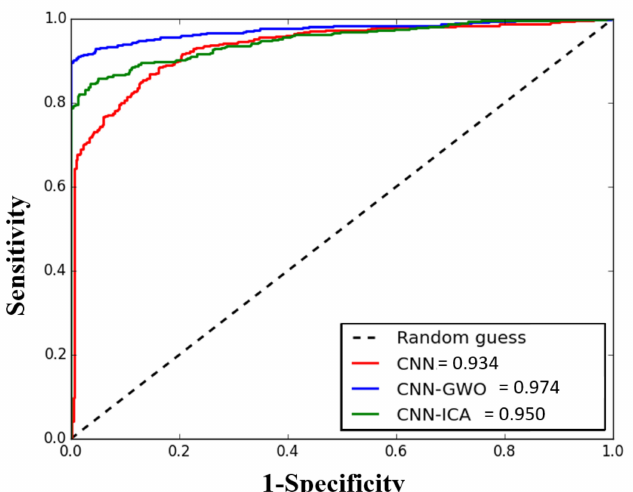
Figure 10. The ROC curves and AUC values of CNN (red line), CNN-GWO (blue line), and CNN-ICA (green line) for wildfire susceptibility models using a testing